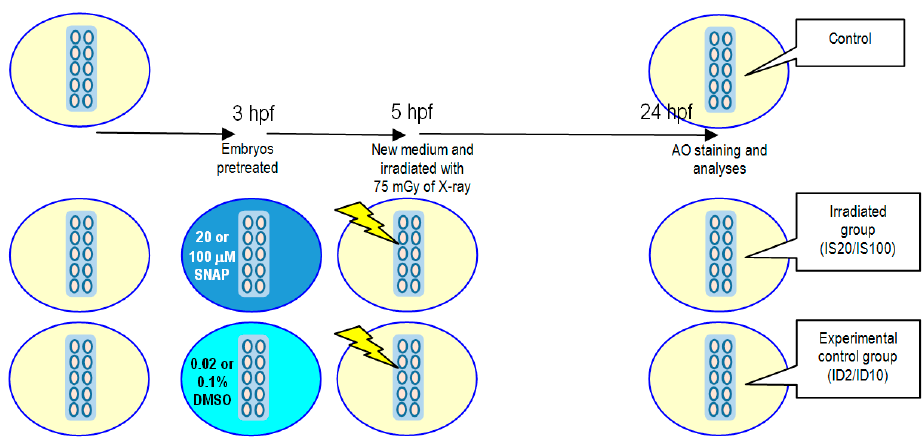
Figure 4. Schematic diagram showing the protocols for studying the influence of SNAP on X-ray-induced targeted effects. Embryos were pretreated with 20 or 100 µM SNAP to form the irradiated groups IS20 or IS100, respectively, or pretreated with 0.02% or 0.1% DMSO for 2 h at 3 hpf to form the experimental control groups ID2 or ID10, respectively. After pretreatment, the irradiated groups and the experimental control groups were transferred to new E3 media and were then irradiated with 75 mGy of X-ray. The embryos were then incubated at 28.5 °C until 24 hpf for AO staining and analyses.